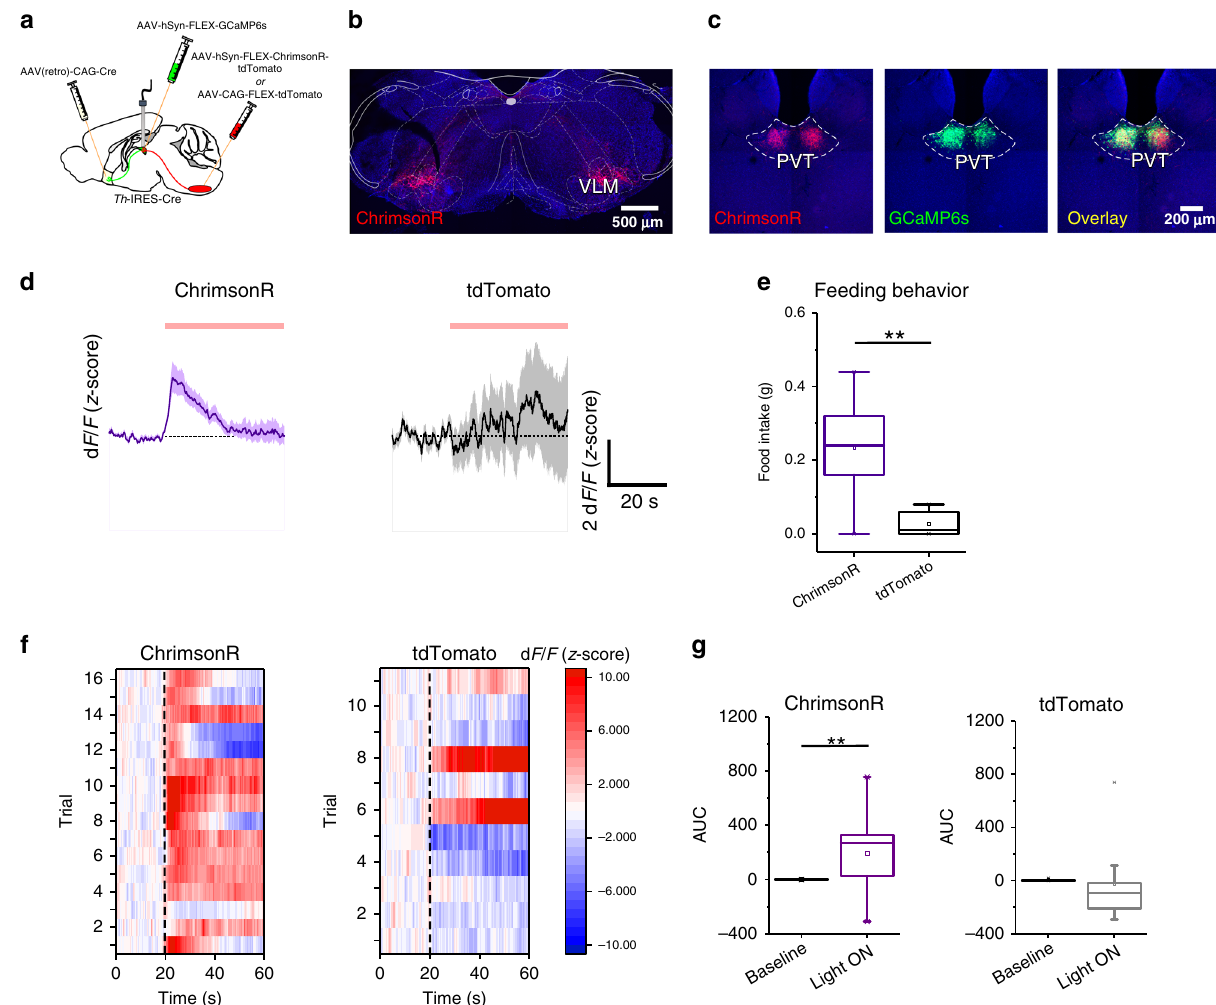
Fig. 3 Photostimulation of VLM CA axonal inputs to pPVT increases the activity of pPVT – NAc neurons. a Schematic of the viral vector strategy and optical fi ber placement used for selectively expressing GCaMP6s in NAc-projecting neurons of the pPVT and red-shifted channelrhodopsin-2 (ChrimsonR- tdTomato) in catecholaminergic neurons of the VLM of TH-IRES-Cre mice. b Representative images from a TH-IRES-Cre mouse expressing ChrimsonR- tdTomato in the VLM. c Representative images of the pPVT showing axonal projections from the VLM (ChrimsonR-tdTomato; left), GCaMP6s expression in pPVT – NAc neurons (middle), and overlay image showing colocalization between the projections from ChrimsonR-expressing VLM neurons and GCaMP6s-expressing pPVT – NAc neurons (right). d Average GCaMP6s responses from pPVT – NAc neurons in ChrimsonR-expressing (purple) and tdTomato-expressing (black) animals subjected to light stimulation. e Quanti fi cation of food intake during VLM CA – pPVT stimulation for both ChrimsonR and tdTomato showing increases in feeding after stimulation in well-fed ChrimsonR expressing mice. Total food intake in grams, ChrimsonR, 0.23 ± 0.05, n = 9 mice; tdTomato, 0.03 ± 0.01, n = 6 mice; two-sided Unpaired t-test, ** P = 0.006. f Heatmap showing individual trial GCaMP6s responses to light stimulation (561 nm at 20 Hz) from both ChrimsonR-expressing and tdTomato-expressing (control) mice. g Left: Quanti fi cation of light-evoked changes in GCaMP6s fl uorescence in pPVT – NAc neurons from mice expressing ChrimsonR in VLM CA neurons. Area under the curve (AUC), Baseline, − 0.21 ± 0.11; Light ON, 190.65 ± 63.27; two-sided Paired t-test, ** P = 0.008. Right: Quanti fi cation of light-evoked changes in GCaMP6s fl uorescence in pPVT – NAc neurons from mice expressing tdTomato in VLM CA neurons. Area under the curve (AUC), Baseline, 1.78 ± 1.83; Light ON, − 23.13 ± 99.86; two-sided Paired t-test, P = 0.79. Box chart legend: box is de fi ned by 25th, 75th percentiles, whiskers are determined by 5th and 95th percentiles, and mean is depicted by the square symbol. Data presented as mean ±